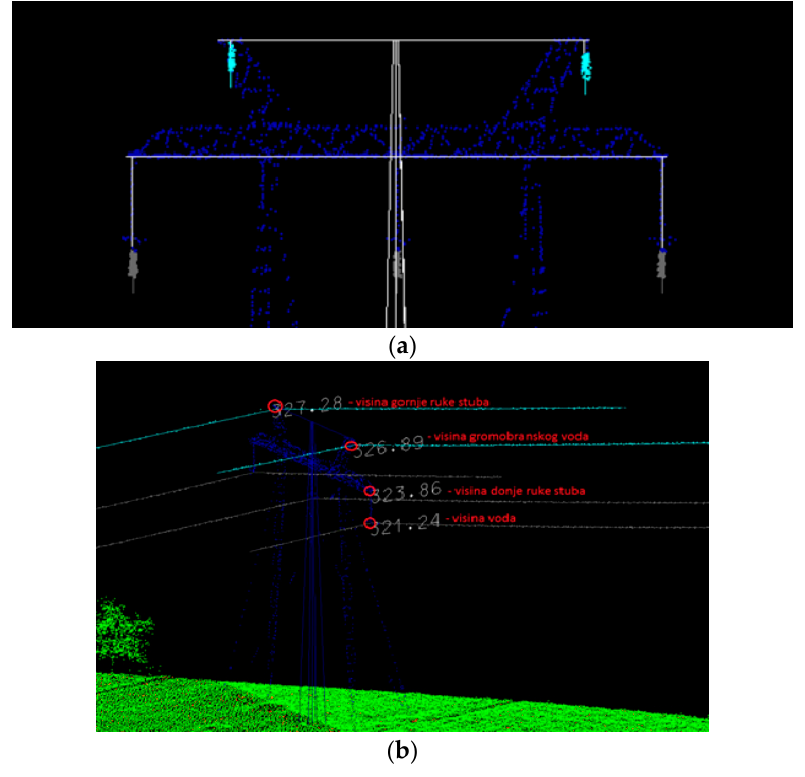
Figure 12. Powerlines. ( a ) a 3D representation of a pole; ( b ) a 3D representation of a pole with Figure12. Powerlines. ( a )a3Drepresentationofapole; ( b powerlines.